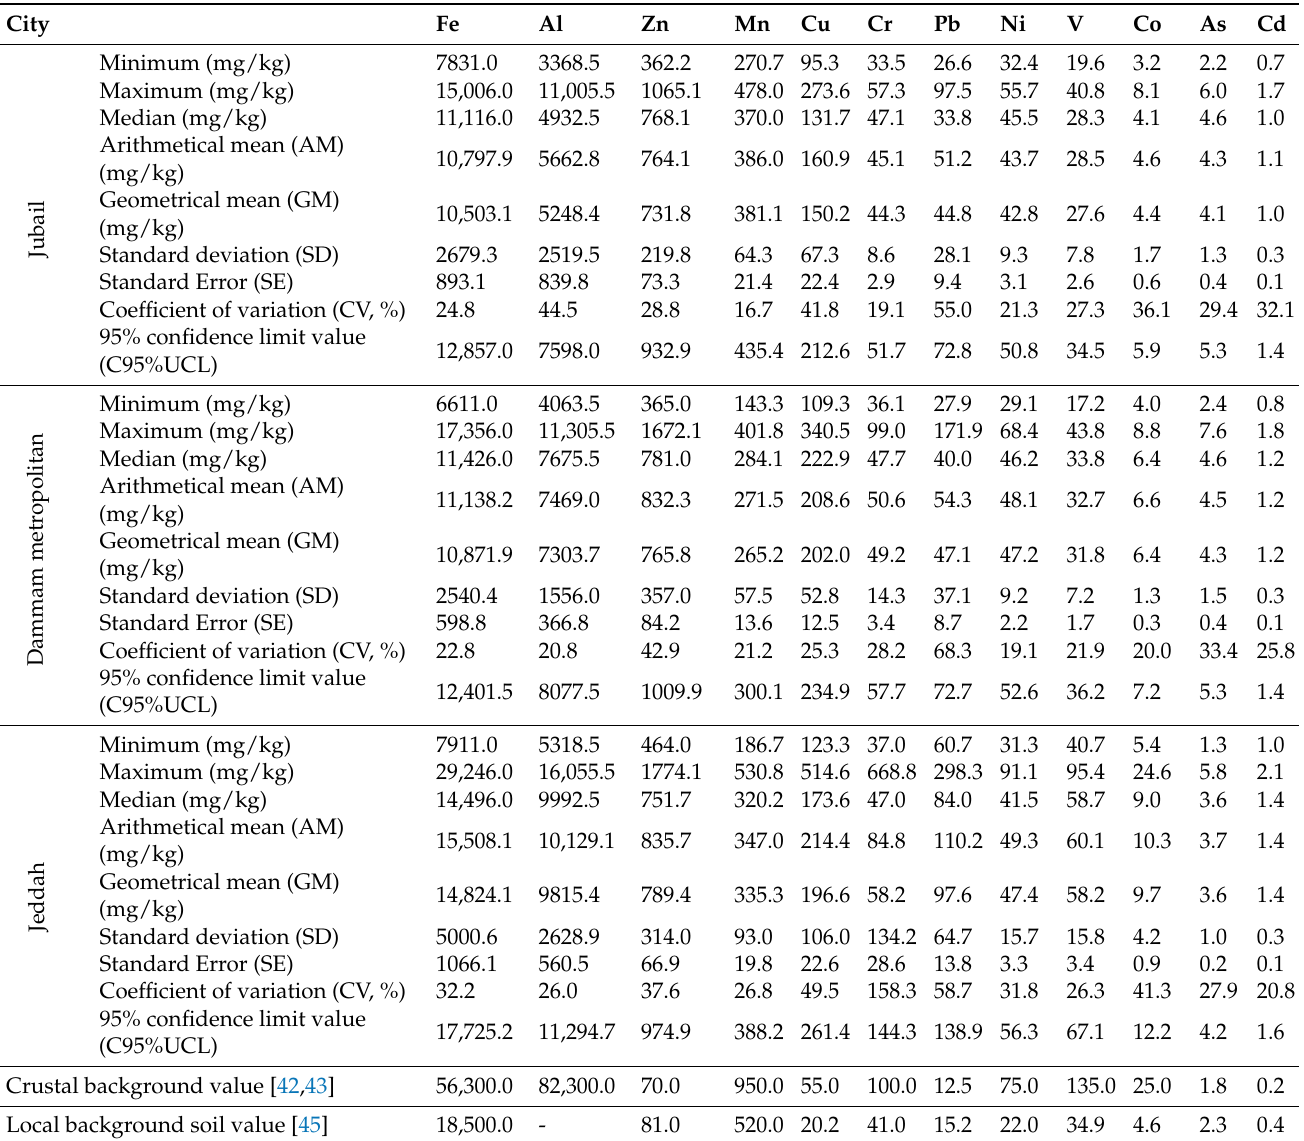
Table 1. Descriptive statistics of PHEs content in ACFD of the mosques in Jubail, Dammam metropoli- tan, and Jeddah